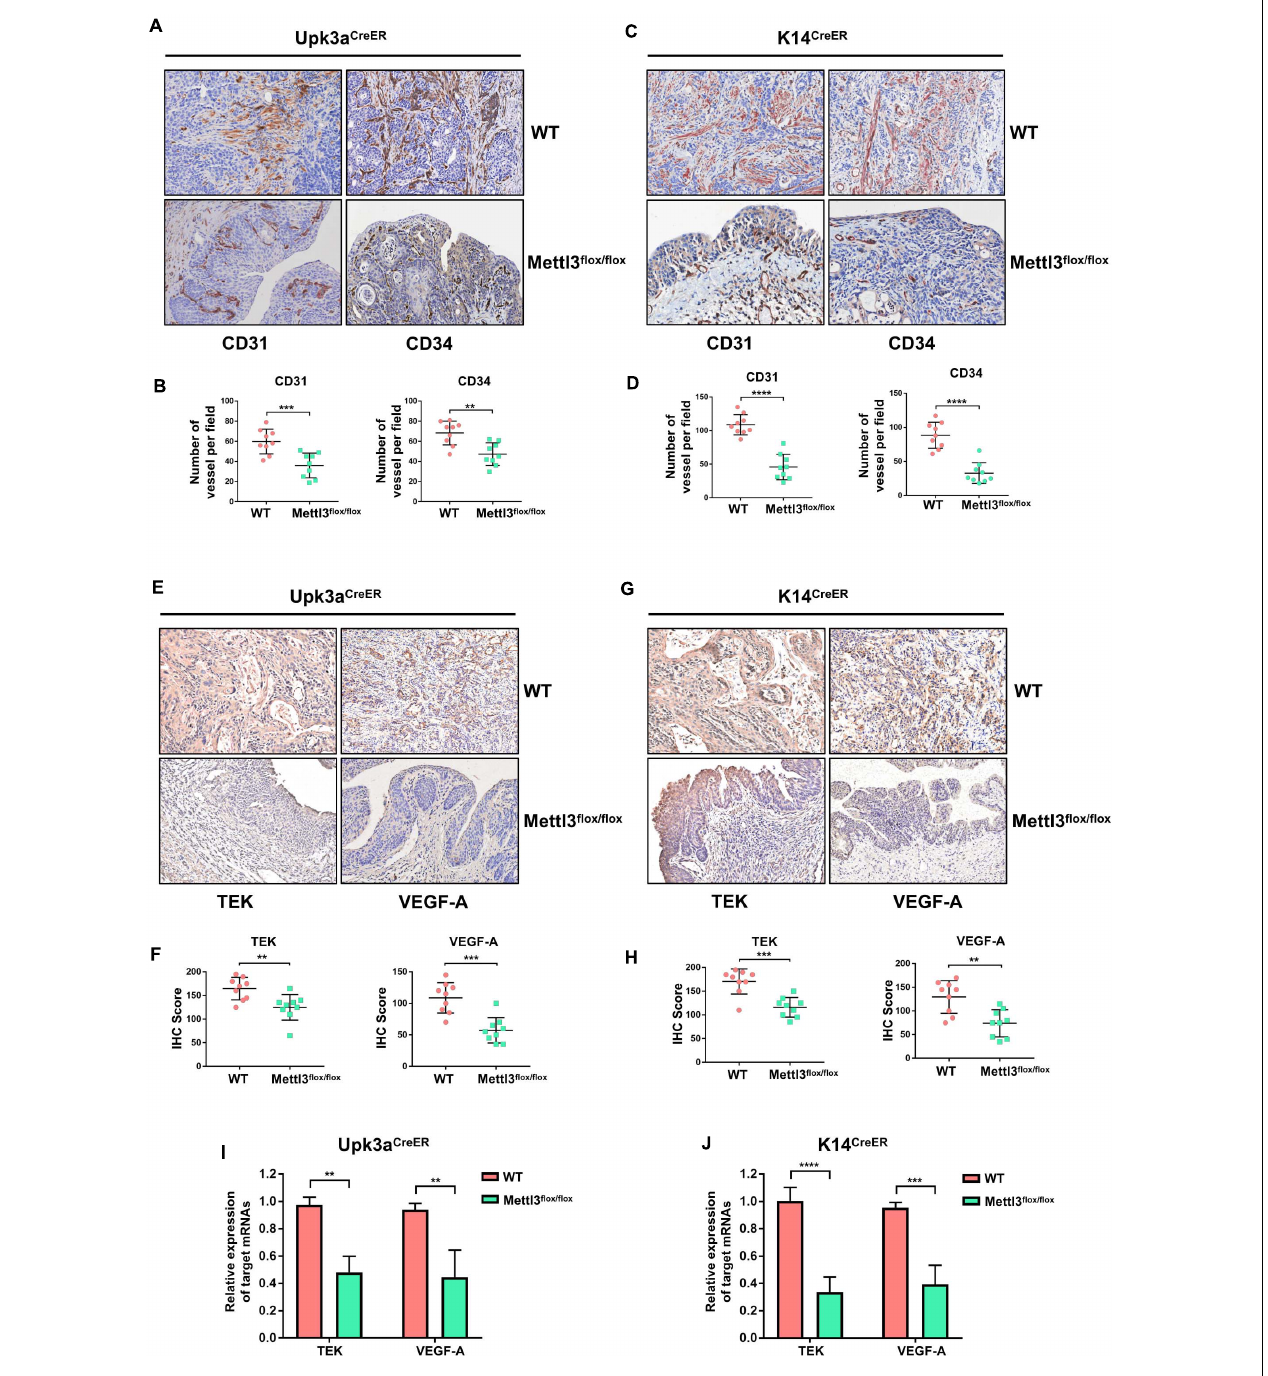
FIGURE 6 | Deletion of Mettl3 repressed tyrosine kinase endothelial (TEK)/vascular endothelial growth factor A (VEGF-A)-dependent tumor angiogenesis. (A) CD31 and CD34 were evaluated by immunohistochemistry (IHC) staining in Upk3a CreER WT (up) and Upk3a CreER Mettl3 KI (bottom) mice. Scale bars, 100 µ m. (B) The expression level of CD31 (left) and CD34 (right) was counted on the basis of their staining intensity and positive cells under a double-blind assessment. (C) Representative images showing IHC staining of CD31 (left) or CD34 (right) upon the sections obtained from K14 CreER wild-type and K14 CreER Mettl3 KI mice. Scale bars, 100 µ m. (D) The variation of CD31 or CD34 caused by deletion of Mettl3 among K14-oringinated cancer cells was quantified by IHC scoring. (E) Representative images of IHC staining for Mettl3 targets. TEK and VEGF-A were dramatically reduced after specific ablation of Mettl3 in urothelial cells. Scale bars, 100 µ m. (F) IHC score showing the difference of TEK and VEGF-A expression in tumor samples. (G) Reduction in TEK and VEGF-A expression level by loss of Mettl3 in cells from which basal layer of the epithelium originated. Scale bars, 100 µ m. (H) IHC score was computed according to the IHC staining of K14 CreER mice with or without eliminating Mettl3. (I) Examination of TEK and VEGF-A mRNAs level from bladder tissue with or without Mettl3 knockout by the qPCR experiments. (J) The transcription level of TEK and VEGF-A in K14 CreER mice was detected by qPCR.